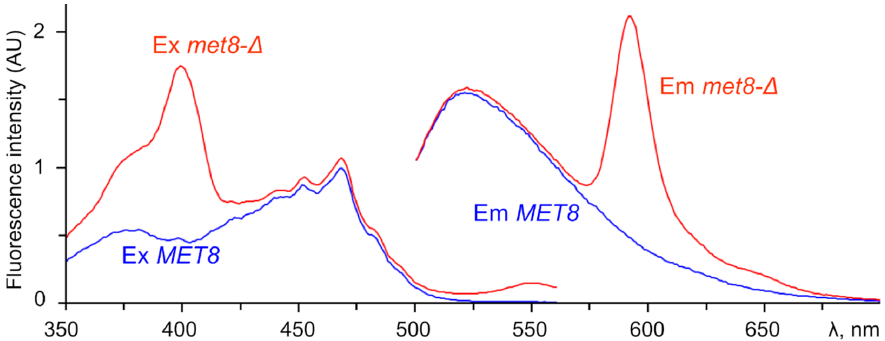
Figure 4. Excitation (Ex) and emission (Em) spectra (recorded at λ em = 595 nm and λ ex = 400 nm, respectively, with 5 nm bandwidth and 1 nm resolution) of cell extracts of O. parapolymorpha met8- ∆ mutant (red) and strain with MET8 wild-type allele (blue).